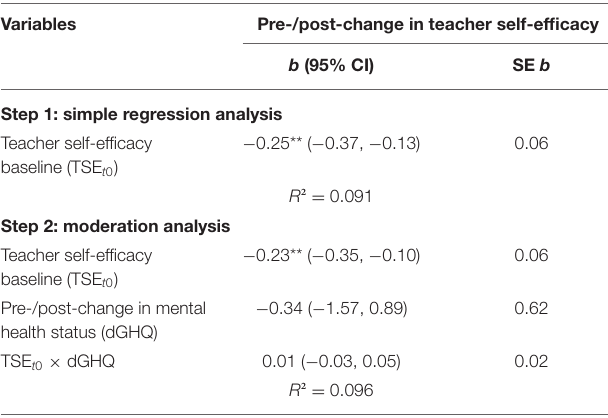
TABLE 1 | Estimates of the main effect of teacher self-efficacy at baseline measure (TSE t 0 ) and the interaction effect of pre-/post-change in mental health (dGHQ) on pre-/post-change in teacher